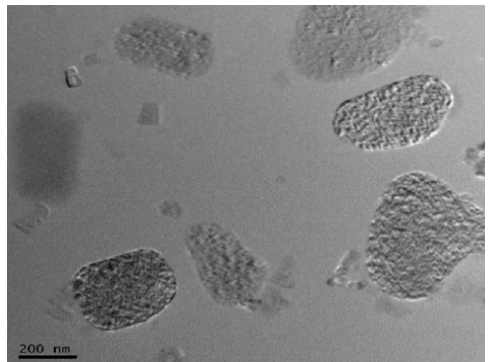
Figure 3. TEM images of MIP membrane.